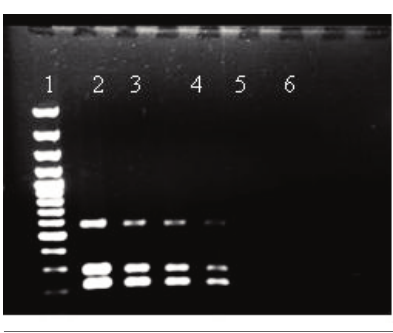
Figure 2. Sensitivity test of triplex PCR of V. cholerae O1. Lane1(ladder100bp),lane 2(1/10dilution), lane3 (1/100 dilution), lane 4(1/1000 dilution), lane 5(1/10000 dilution), lane6(1/100000